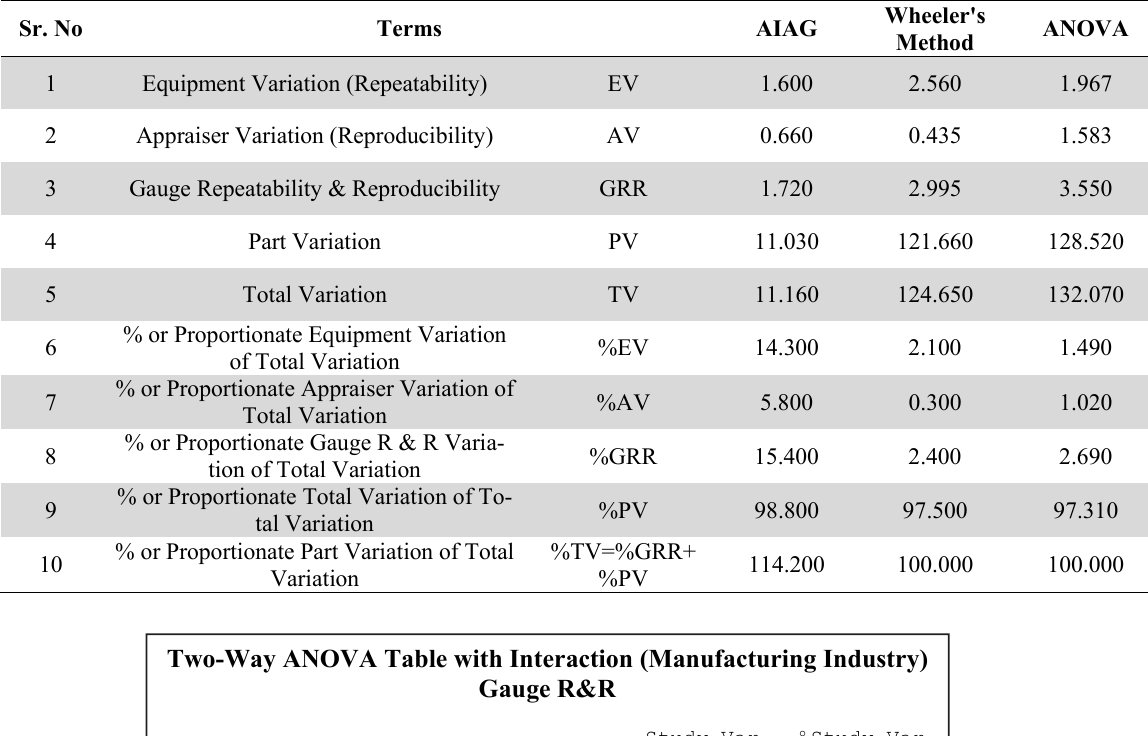
Comparison Sheet of Various MSA Methods (Manufacturing Industry) Measurement System Analysis of a Vernier Calliper in a Manufacturing Industry